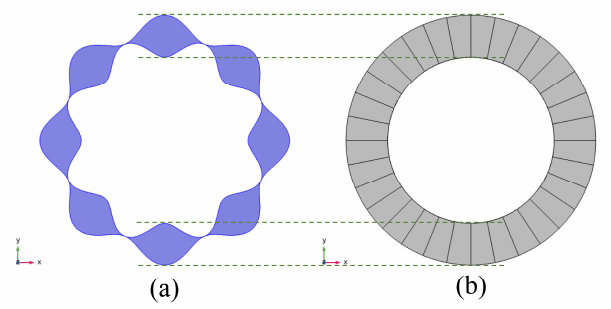
Figure 1. Structure of the capacitor angle sensor: ( a ) petal-shaped rotor and ( b ) fan-shaped stator.